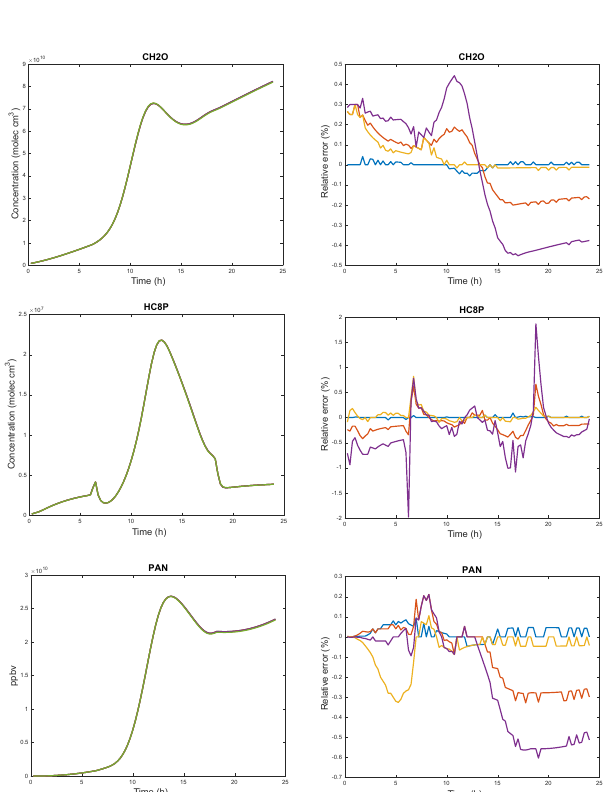
Figure 2. FLUX case. Same as Fig. 1 for CH 2 O, HC8P (peroxy radicals), and PAN (peroxyacetyl